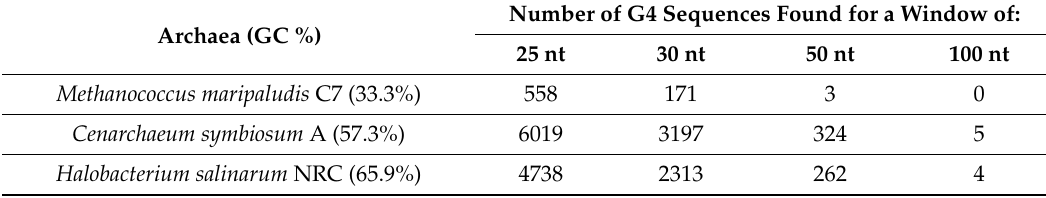
Table 1. A number of putative quadruplex sequences (PQS) were found using four di ff erent window sizes in three complete archaeal